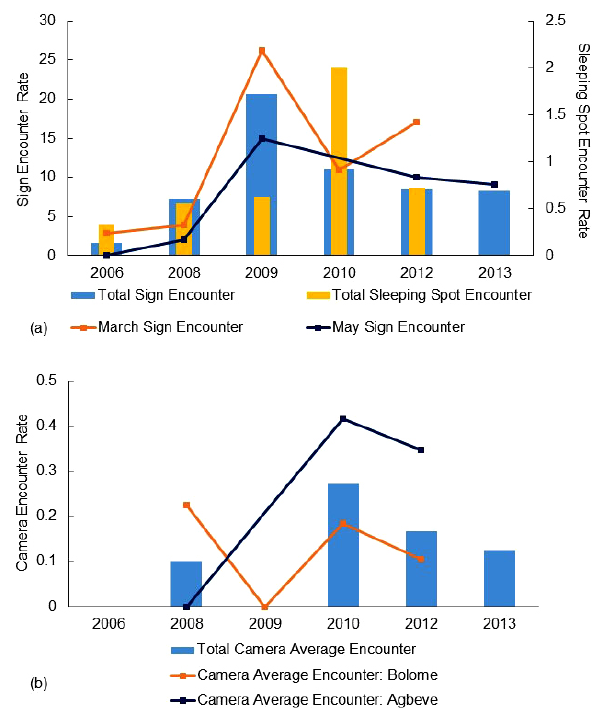
of search effort, with clustered observations near access channels and the location of other fieldwork (Fig. 2). A convex polygon connecting the outermost locations of recorded sitatunga signs suggests a minimum spatial distribution of 5143.2 hectares of favorable habitat interspersed with settlements (Fig. 2). Temporal trends are confounded by variation in the duration, location, area coverage, and season of surveys and so can provide only a very coarse indication of trends. All four abundance indicators we extracted from hunter-aided survey data, however, are suggestive of an initial increase after implementation of the hunting ban in 2006, with peak abundance in 2009-2010 and a subsequent reduction to levels below peak but still well above 2006 levels (Fig. 4). Fig. 4 . Temporal trends in encounter rates during (a) hunter- aided surveys and (b) camera trapping conducted between 2006 and